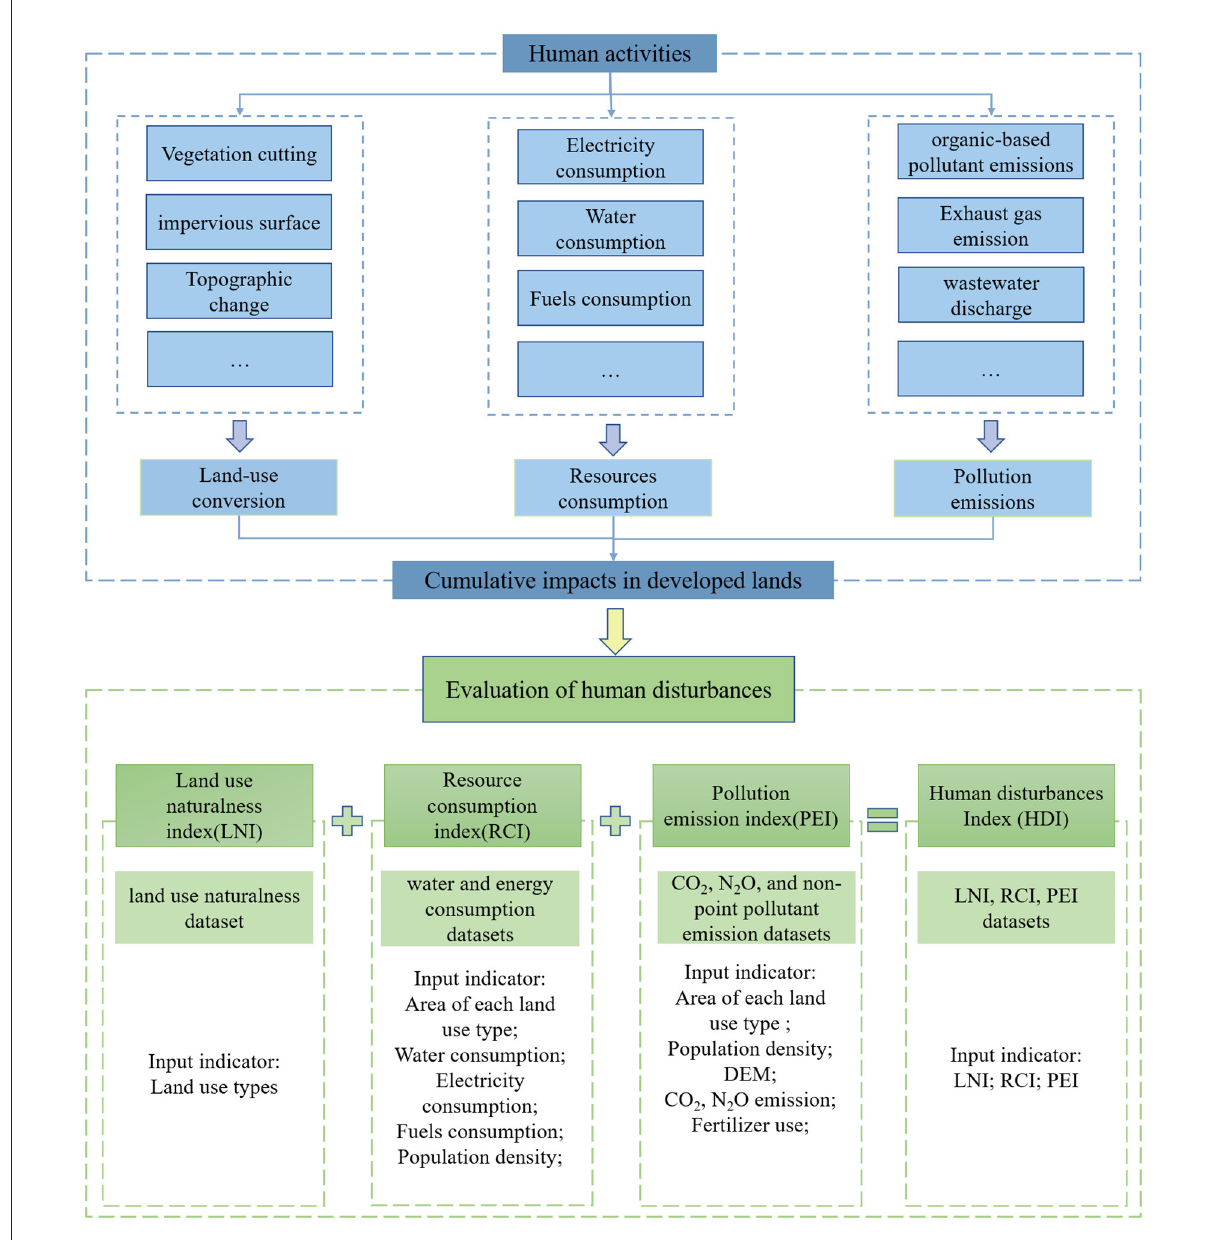
FIGURE1 Conceptual framework of